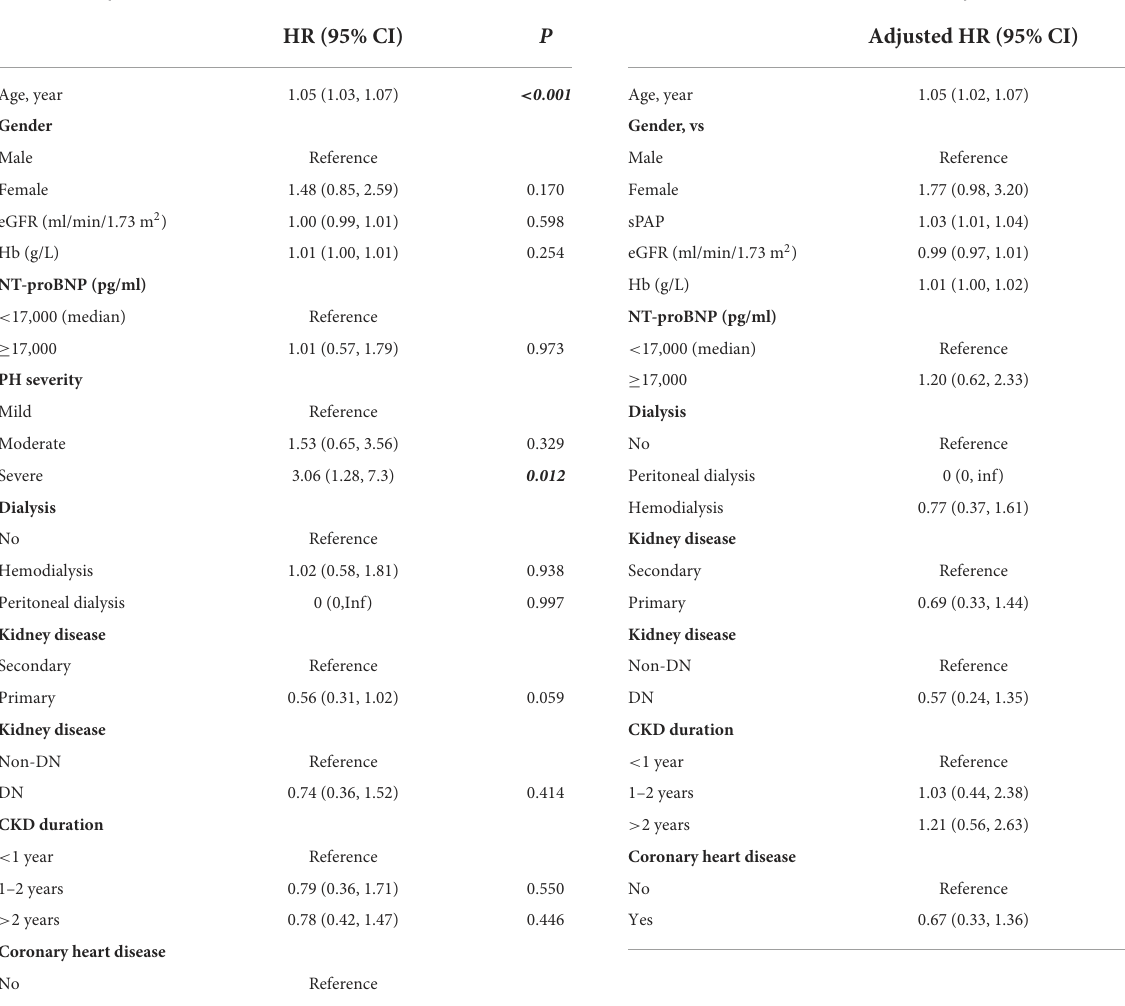
TABLE 4 Univariate analysis of factors associated with survival of all CKD with PH patients.